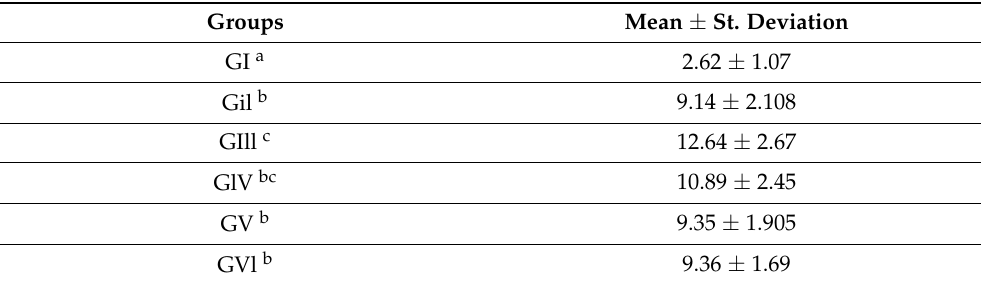
Table 4. The mean values with standard deviations for each group’s shear bond